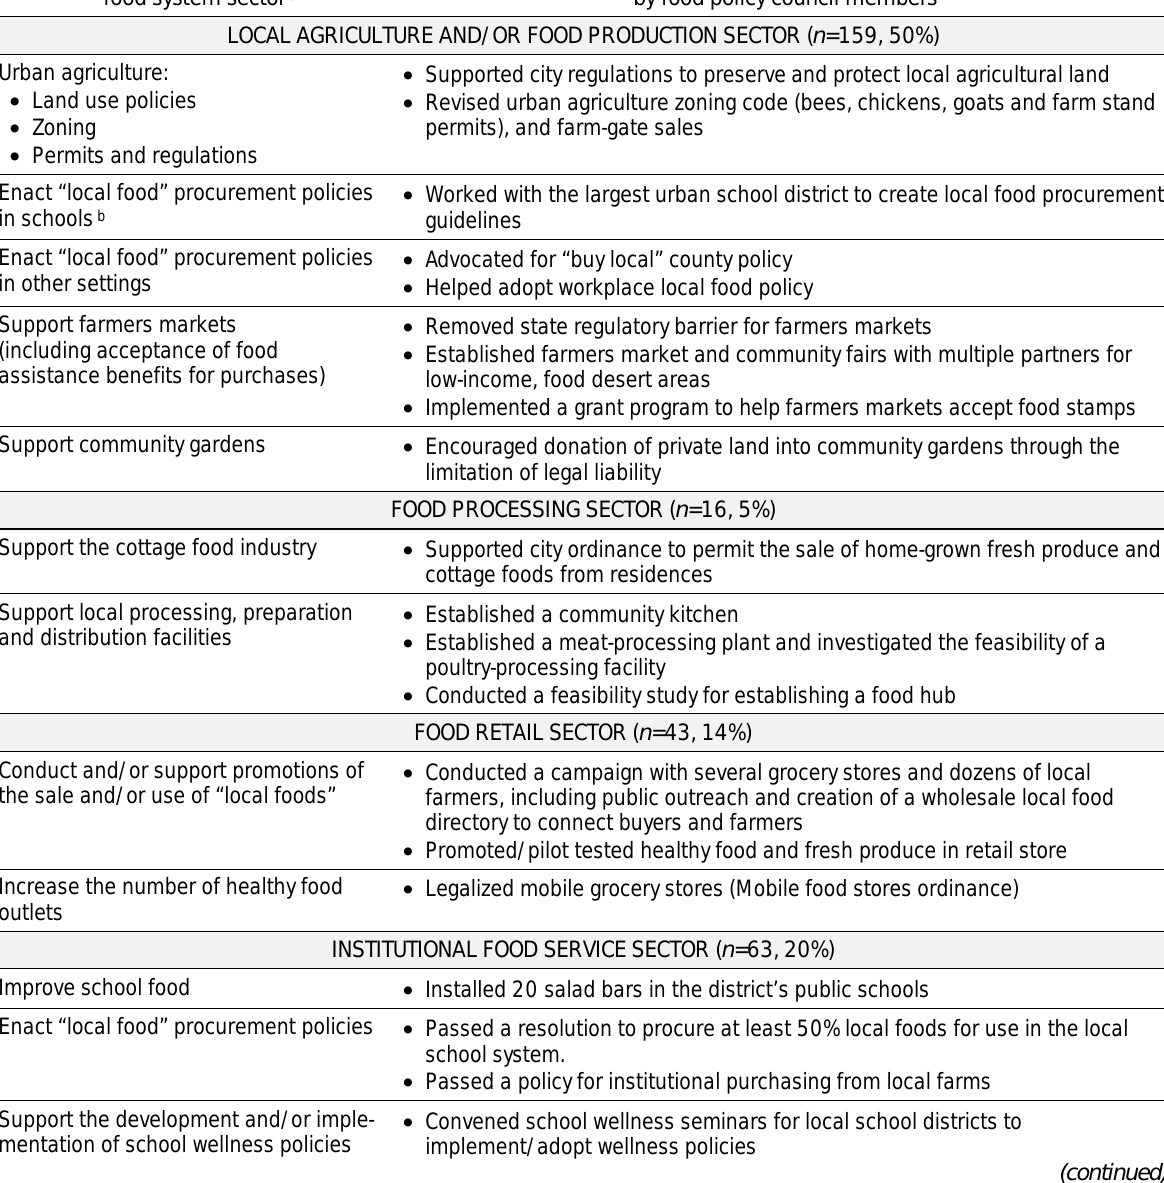
Table 2. Policy, Systems, and Environment Initiatives (PSE) by Topic and Sector of the Food System Reported by Members of 66 Food Policy Councils in 2015 PSE initiative topic